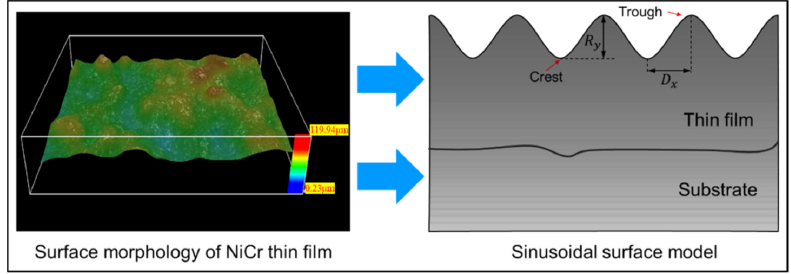
Figure 3. Simplified schematic of heterogeneous surface morphology.